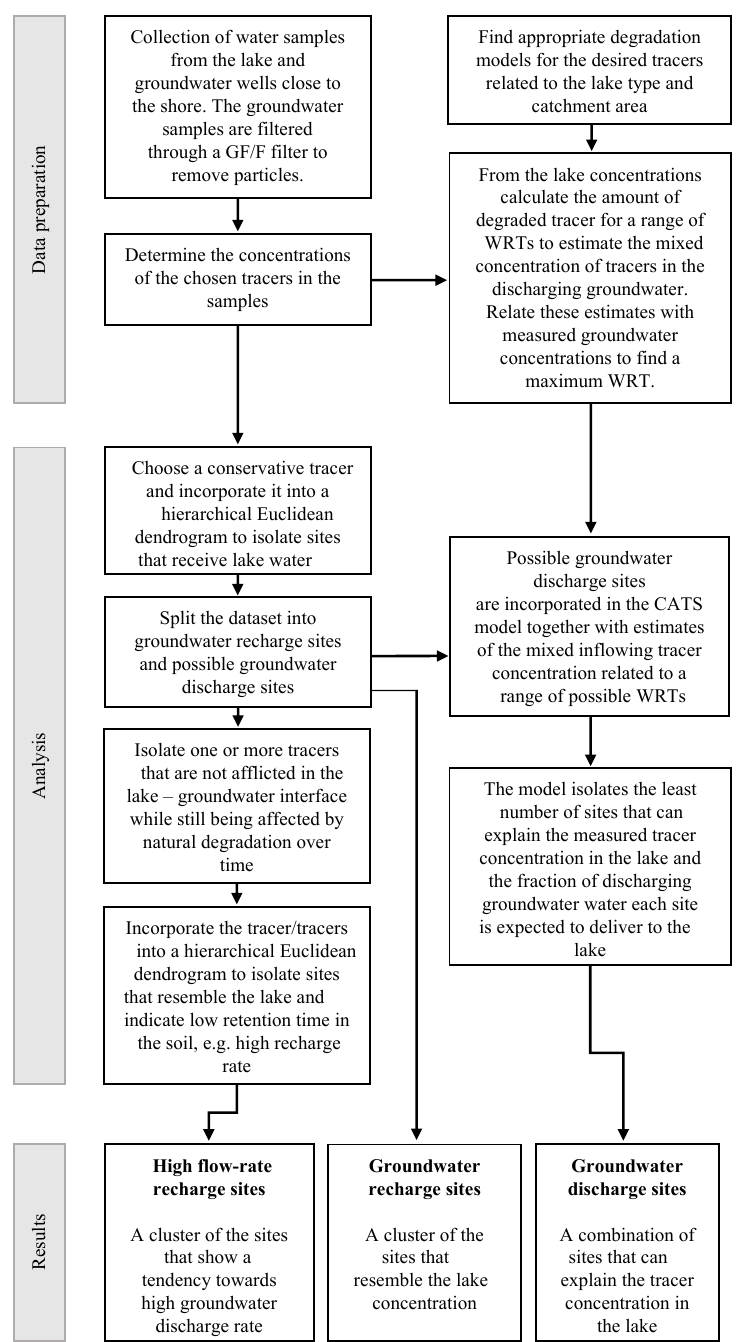
Figure 2. Diagram showing the workflow from data preparation to analysis to the results.